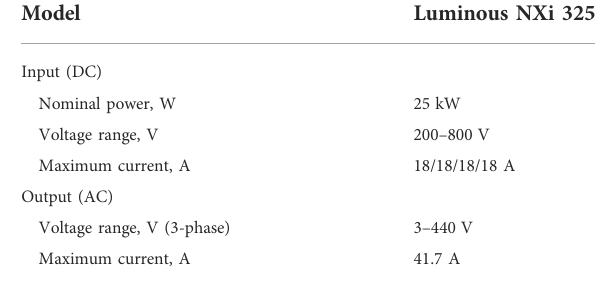
TABLE 3 Inverter speci fi